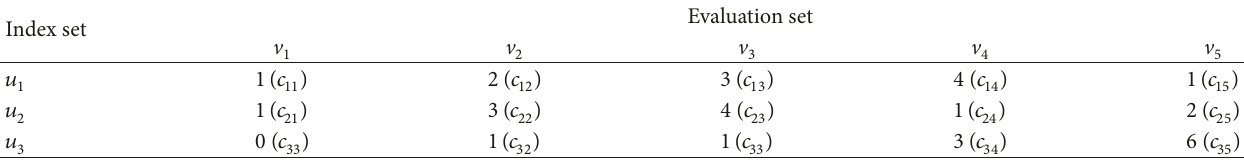
Table 5: Vote distributions of sensory evaluation of sample 1.